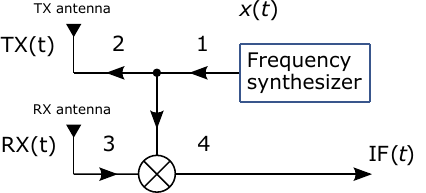
Figure 4. Simple block diagram of a generic monostationary FMCW radar with a single transmitter and single receiver.